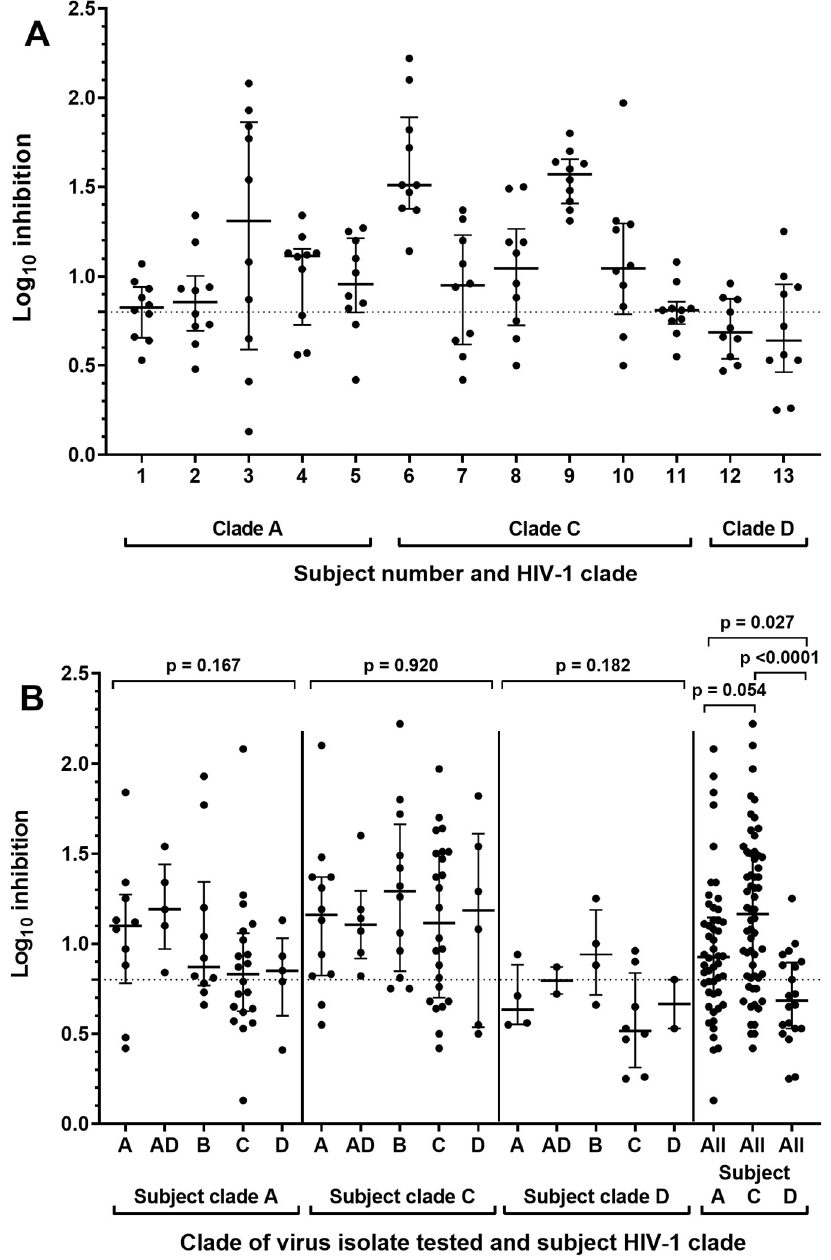
Fig 4. CD8 T-cell mediated inhibition of HIV-1 replication in autologous CD4 T-cells. A) Inhibition for each subject living with HIV, arranged by subject HIV-1 clade, B) Inhibition arranged by subject HIV-1 clade and test HIV- 1 LucR IMC clade. Each of the 3 left panels, inhibition values for test viruses of the same clade are grouped together for subjects living with the same HIV-1 clade (A, C or D clades). In the right panel, inhibition values for all test viruses are grouped by subject HIV-1 clade. Bars represent the medians with interquartile ranges, the dotted line represents the assay positivity value ( > 0.8 log10).